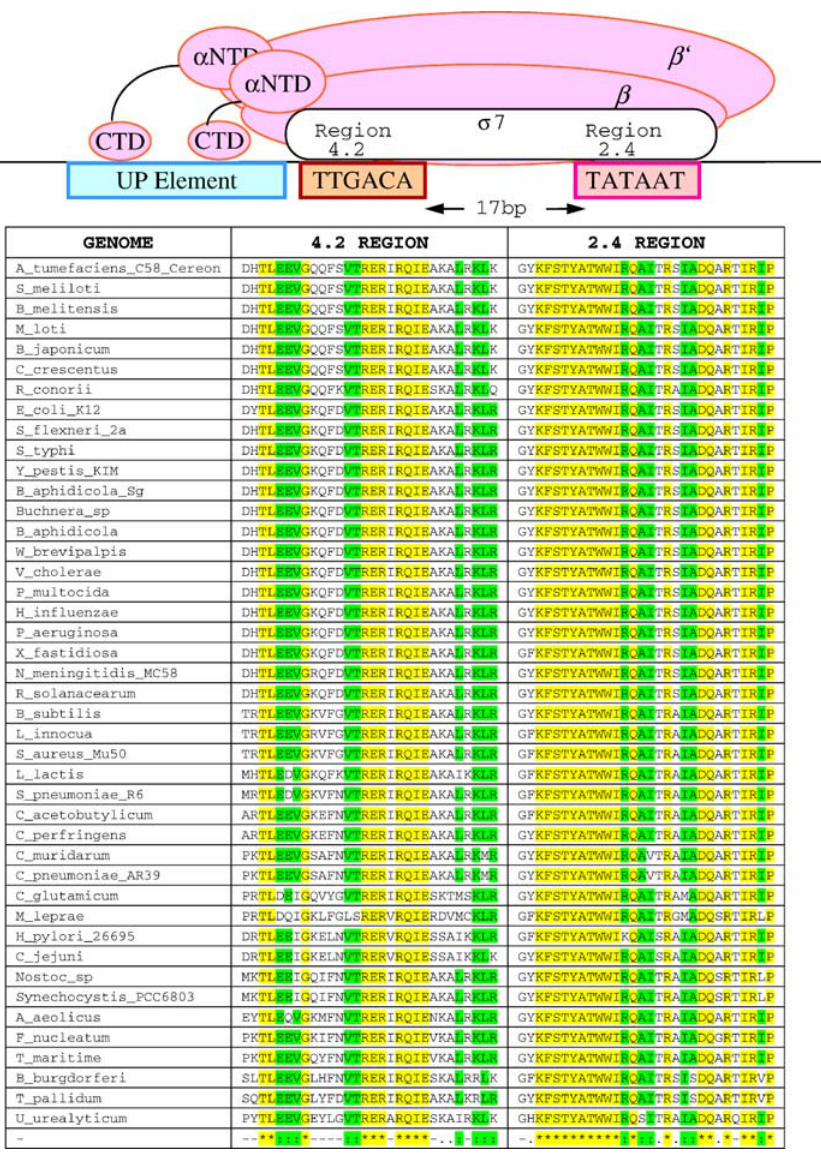
Figure 1. Schematic Representation of the Main Interactions of RNAP with Promoter DNA and Alignment of the r 70 Motifs for Recognition and Binding of (cid:1) 10 (2.4 Region) and (cid:1) 35 Promoter Sequences (4.2 Region) for Representative Eubacteria Sequence alignments of several r 70 factors from different bacteria reveal four conserved regions that can be further divided into subregions [39]. Only regions 2 and 4 are well conserved in all members of the r 70 family [40–43] and include subregions involved in binding to the core RNAP complex, promoter melting, and recognition of the (cid:1) 10 and (cid:1) 35 promoter sequences (regions 2.4 and 4.2, respectively) [10,40,44]. CLUSTALW was used to generate the alignment with default parameters (http://www.ebi.ac.uk/clustalw)